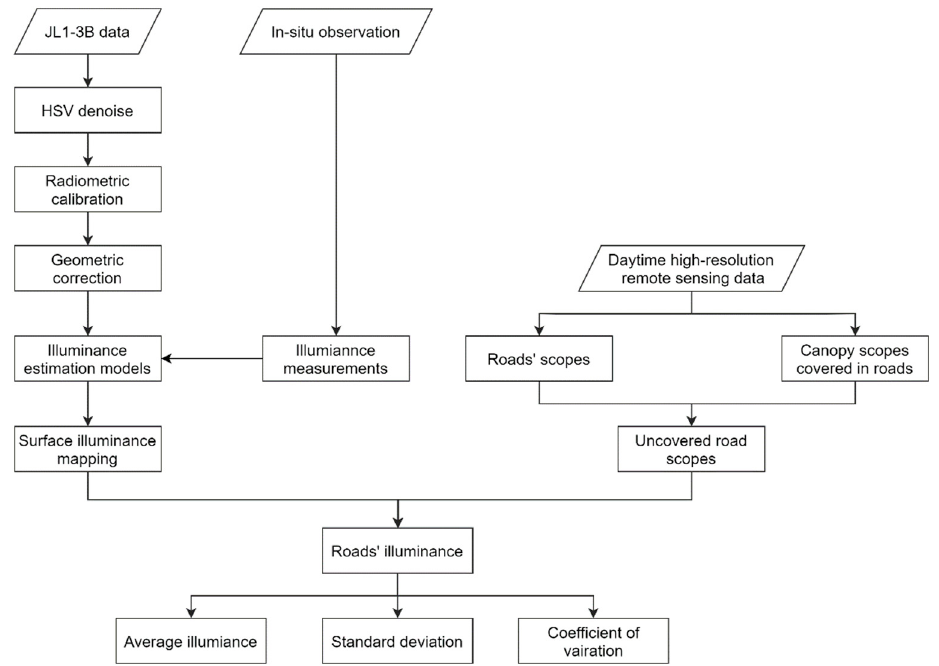
Figure 3. Flow chart.